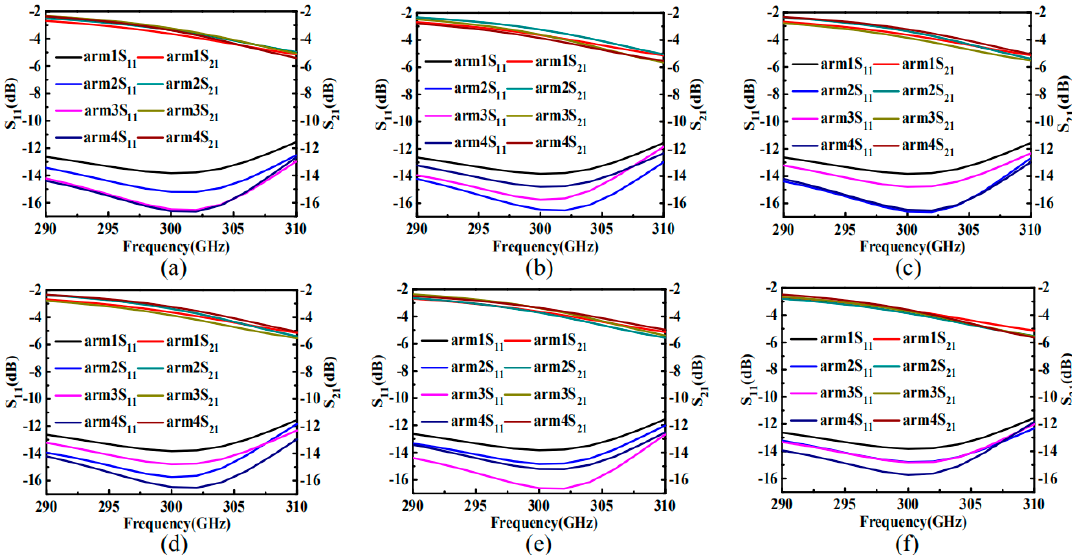
Figure 2. S-parameters of radiation patch obtained from each arm of feeding line in ( a ) element 2 ( b ) element 3 ( c ) element 4 ( d ) element 5 ( e ) element 6 ( f ) element 7.